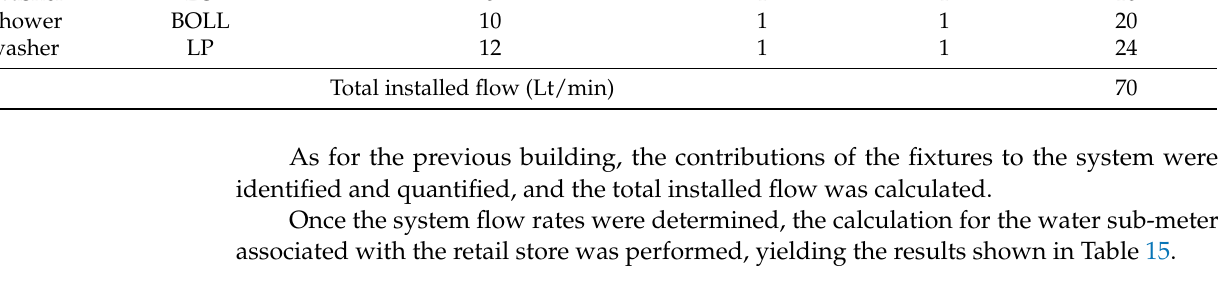
Table 15. Sub-meter calculation report for type 1 retail store.